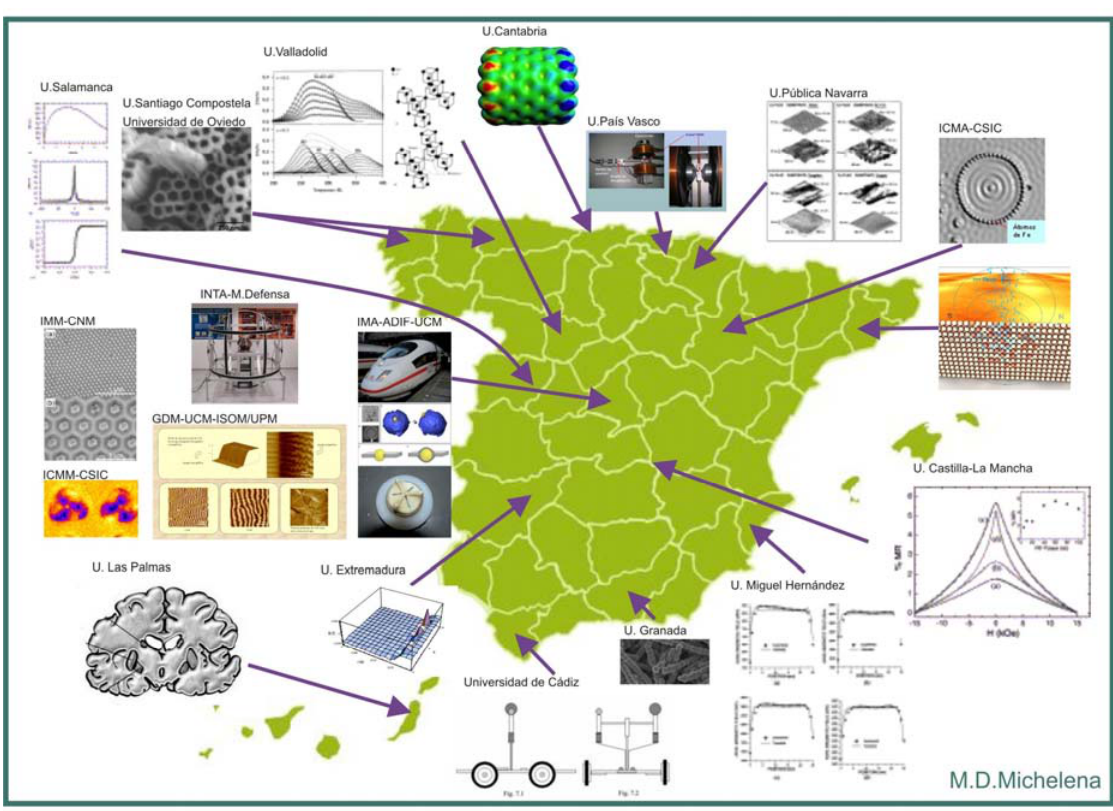
Figure 1. “Spanish Magnetic